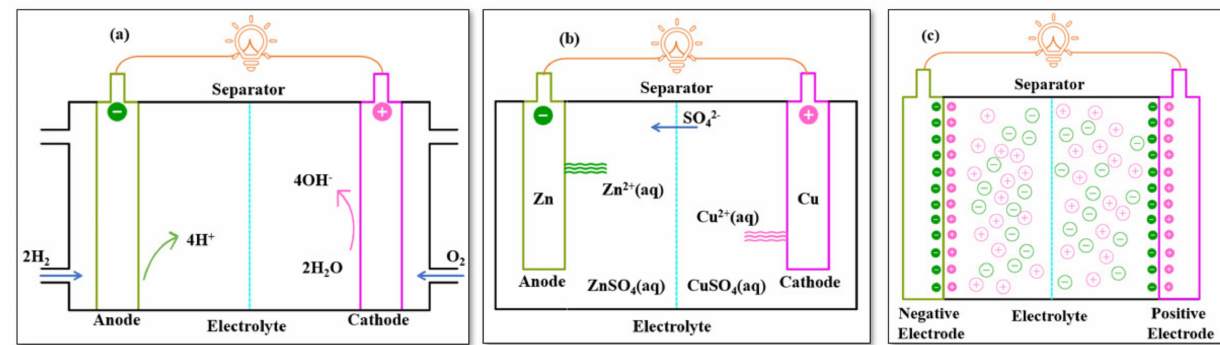
Figure 1. A typical device configuration of ( a ) fuel cell, ( b ) battery, and ( c )